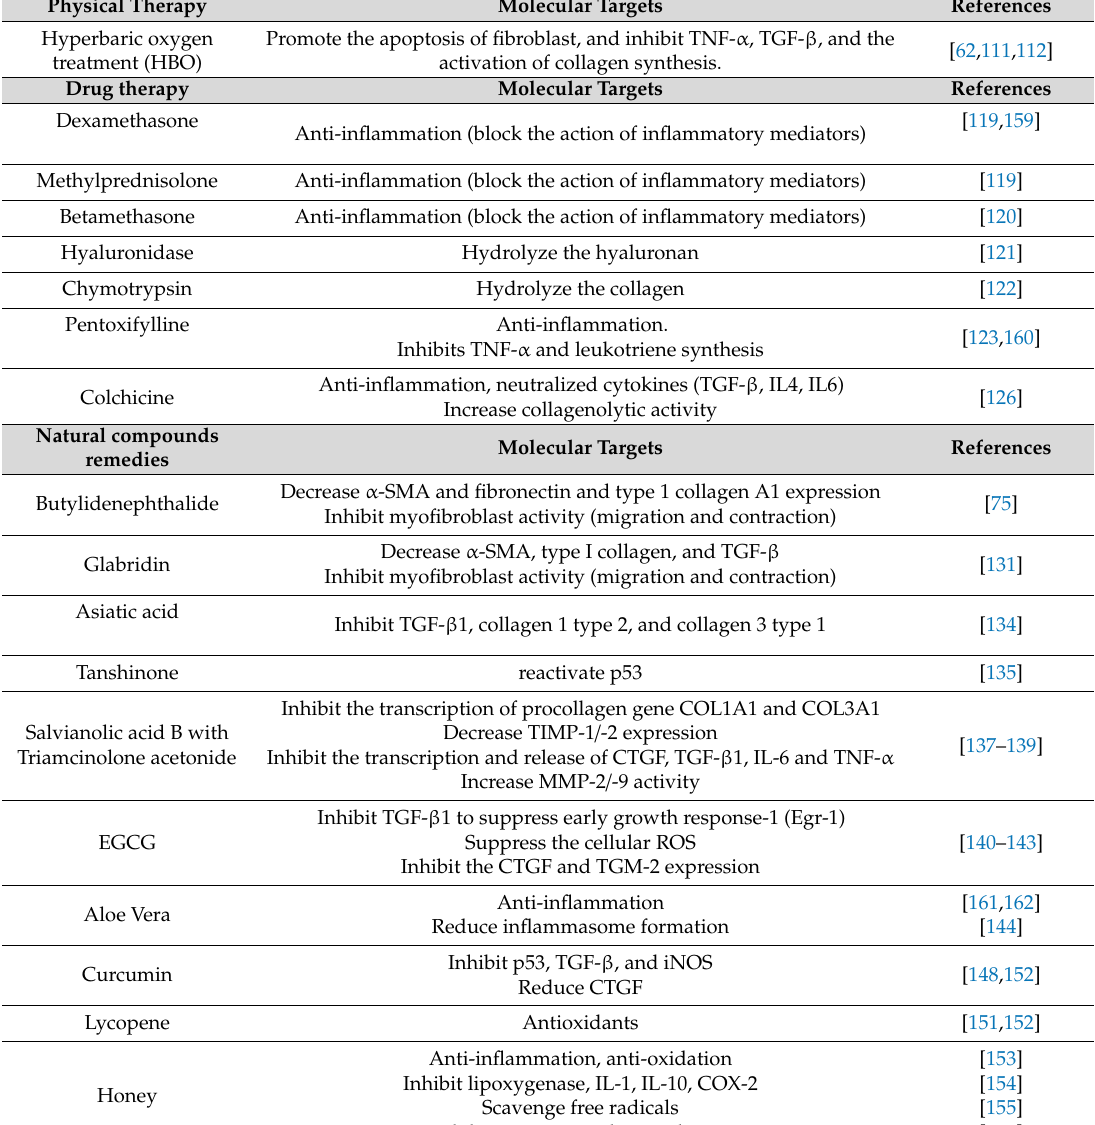
Table 2. Summary of the conservative therapy of OSF and the molecular targets of each